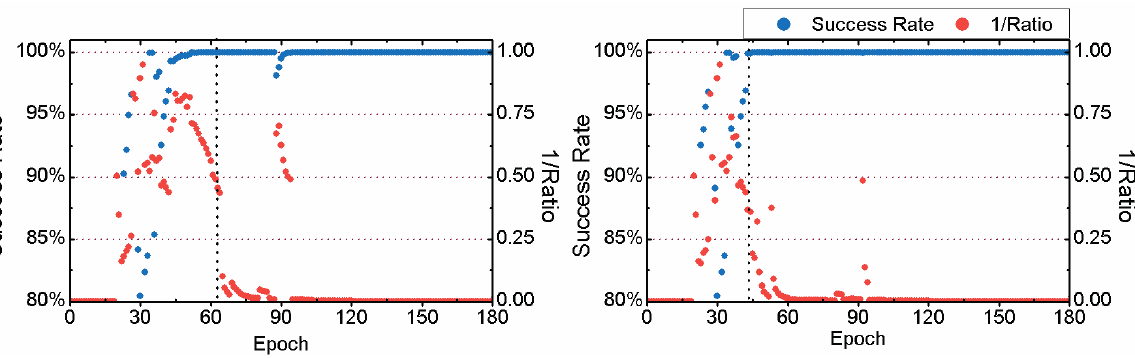
Figure 6. Success rate and reciprocal of the ratio test value for kinematic PPP for the observations of the 6th session from MAS1 on 24 January 2012, achieved by FAR ( Left ) and PAR ( Right ),